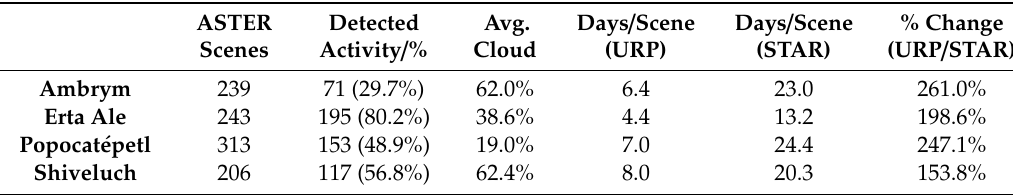
Table 3. Statistical analysis of four volcanoes from Table 2 active during the longer global URP period (1 January 2014–31 May 2019). Each ASTER scene was inspected for confirmed / detected volcanic activity (e.g., thermally elevated pixels, presence of a plume) and average cloud cover. The percentage of those URP scenes with confirmed activity is also given and generally correlates to the average cloud percentage. The time between scenes decreases dramatically for the URP operations as compared to the ASTER Volcano STAR. The last column shows this improvement percentage in the number of days between scenes using the URP versus the STAR scheduling. ASTER Detected Avg. Activity / % Cloud